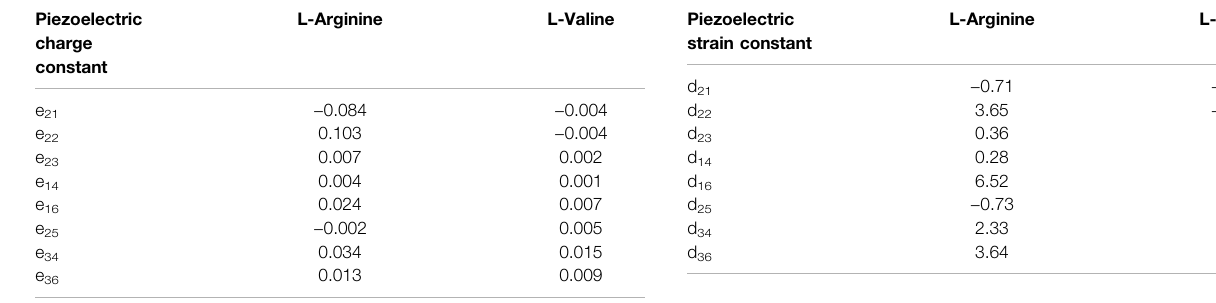
TABLE 1 | DFT-predicted piezoelectric charge tensor components of L-Arginine and L-Valine single crystals. All values are in C/m 2 . Piezoelectric charge constant